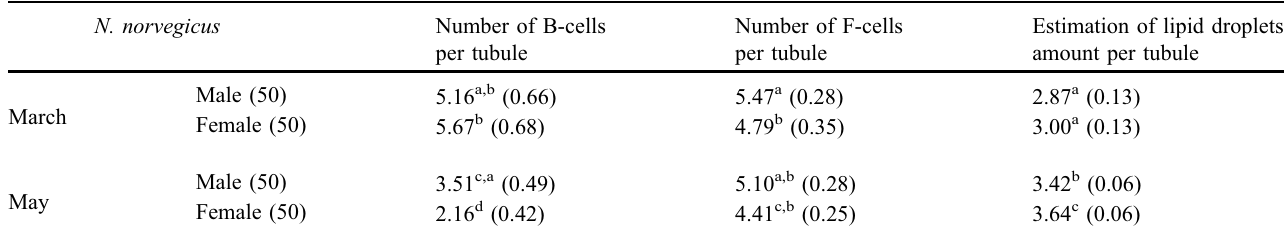
Table 3. Number of B-cells, F-cells per tubule and estimation of lipid droplets amount per tubule from the digestive gland of N. norvegicus compared between months and sex, with number of the measured tubules in brackets. Results are given as means with standard error of mean within parenthesis. Means in a column followed by the same superscript are not signi fi cantly different ( p > 0.05). N.